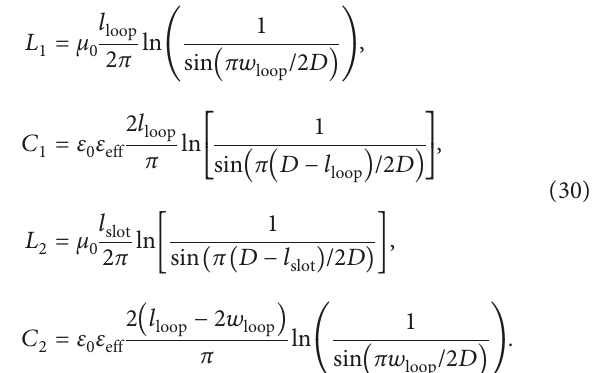
| of the FSS at normal incidence. (b) | S 21 | of the FSS with optimal sizes fine-tuned by full-wave 21